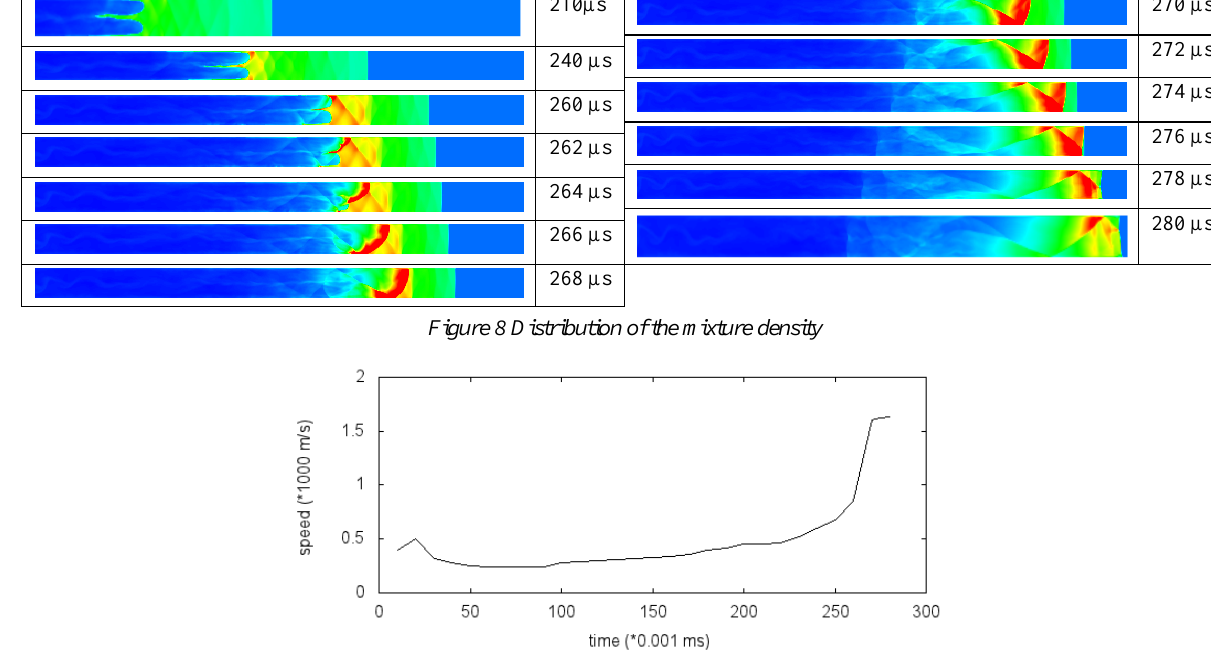
Figure 9 Speed of the combustion wave